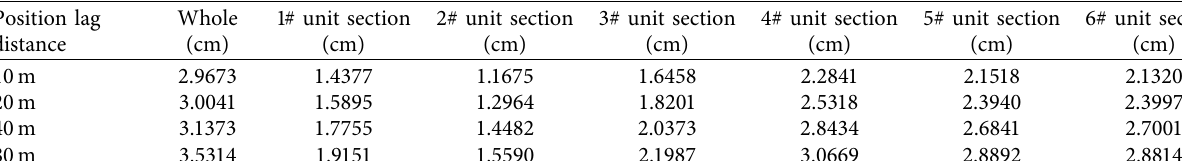
Figure 15: Displacement nephogram when the prestressed anchor lags behind the working face by 40 m ( > 1 cm). Table 4: Maximum displacement at different positions.